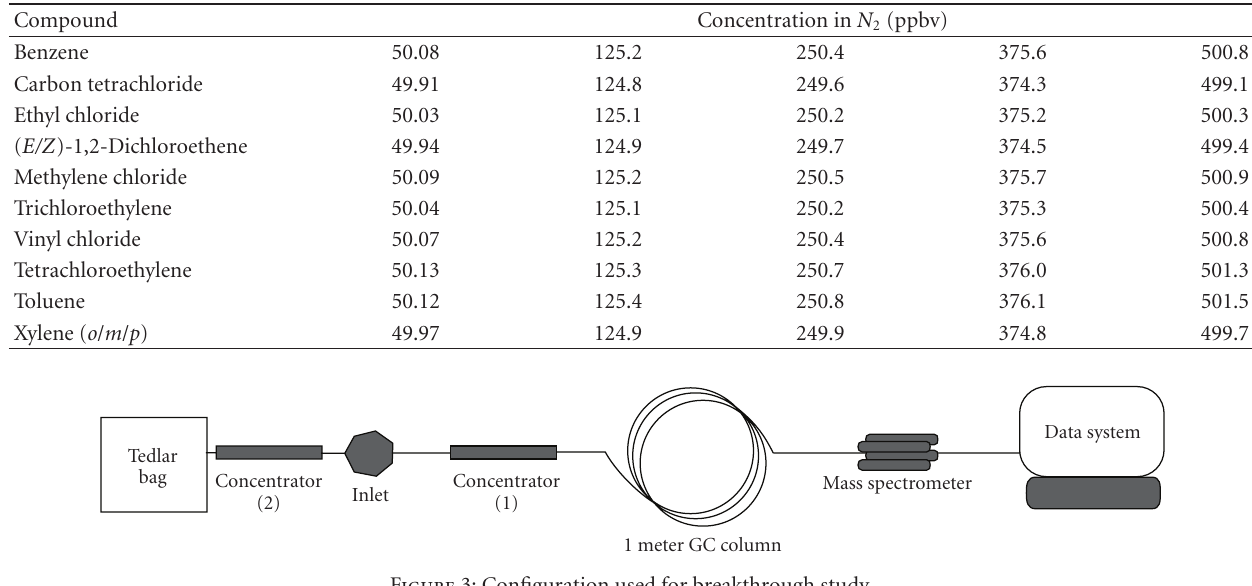
Table 3: Concentrations used to construct calibration curves.